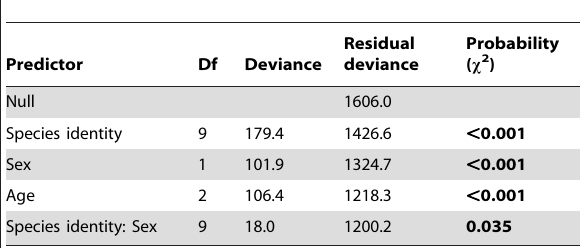
Table 2. Analysis of deviance for expected mite abundance in the observational study, according to species identity, sex, age and the interaction species: